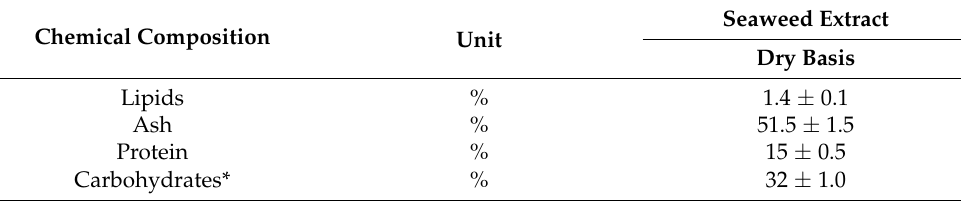
Table 1. Chemical composition of LFR from M. pyrifera . Chemical